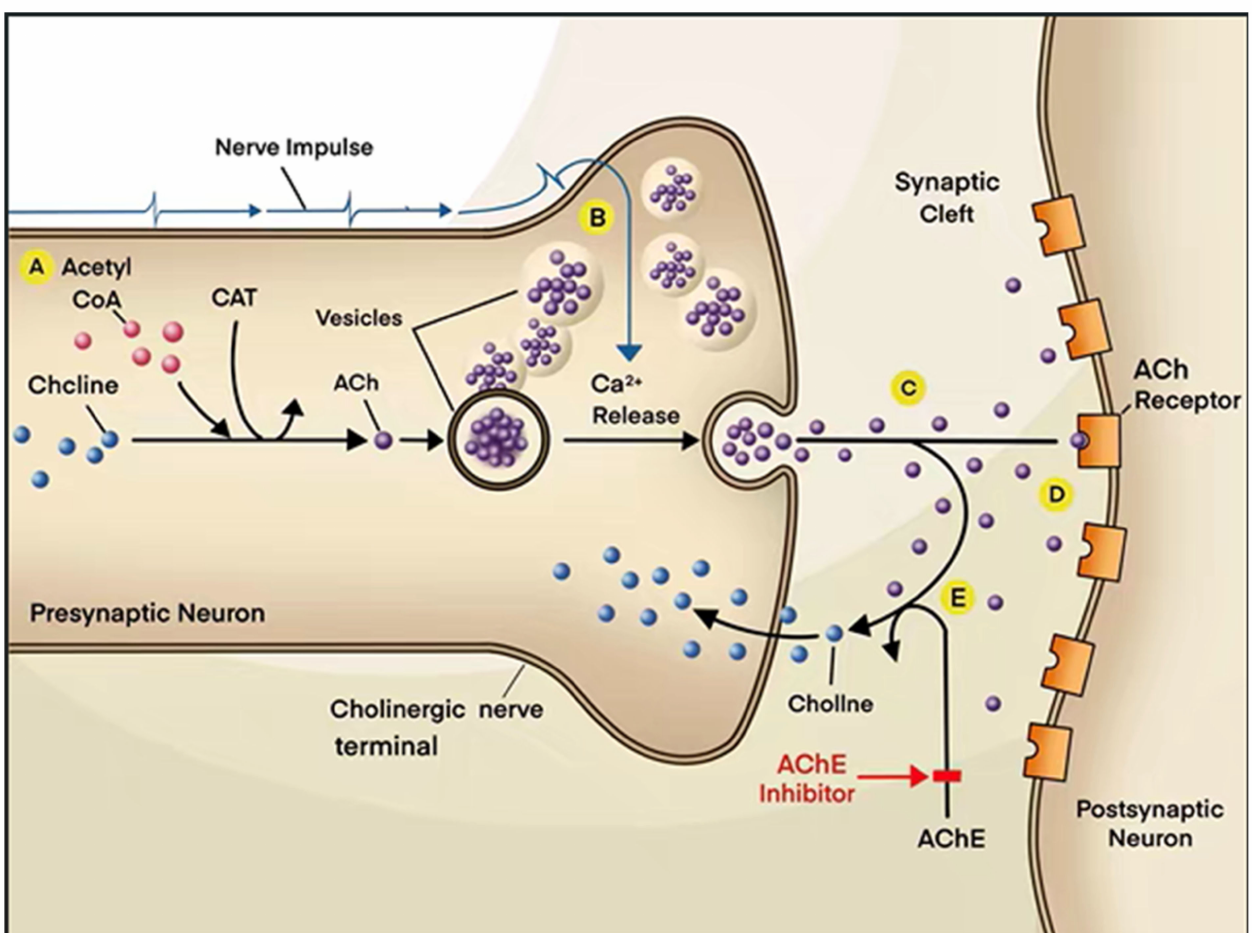
Figure 2. Schematic diagram of AChEI. ACh released from the presynaptic membrane into the synaptic cleft is normally rapidly hydrolyzed by AChE into choline. Choline is re-ingested by the presynaptic neuron to synthesize new ACh. People with AD have deficiency of ACh, and the levels of ACh in their brains are much lower than in normal people. AChEIs can inhibit the activity of AChE and thus block the hydrolysis of ACh, which can increase the concentration of ACh in the synaptic clefts and prolong the duration of ACh action in order to alleviate the cognitive impairment of AD patients. A, B, C, D, E refer to step A, B, C, D, E, which are the processes by which ACh is synthesized and metabolized in the